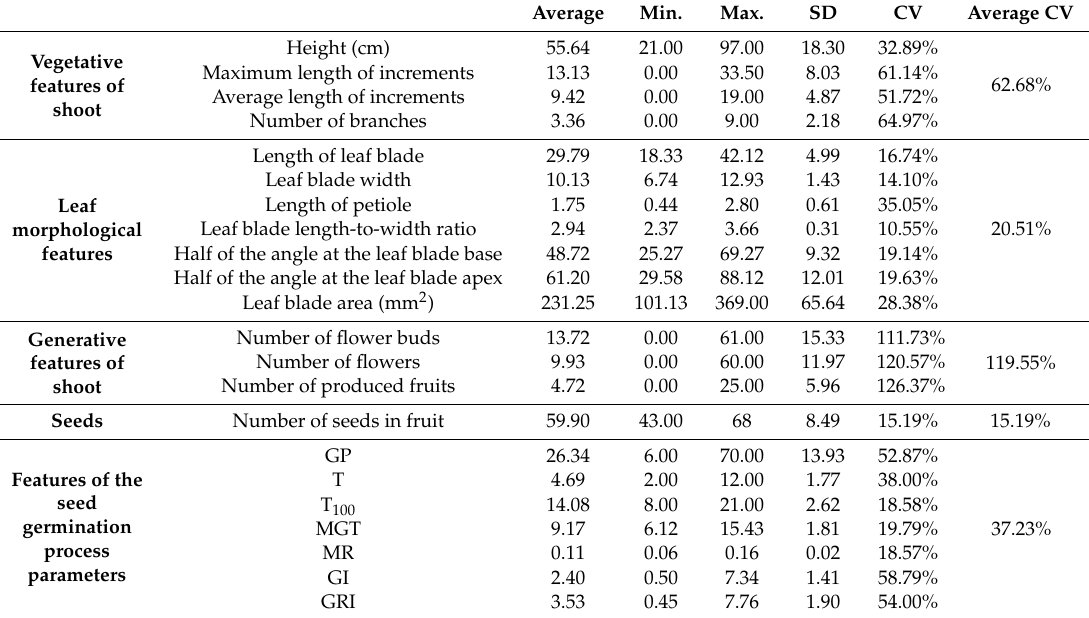
Table 1. The basic statistics of quantitative variables of vegetative features of the shoots; morphological features of leaves; generative features of shoot and features of seed germination process in the